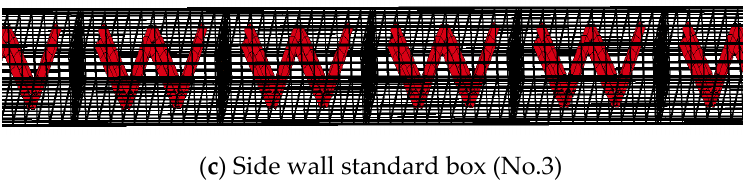
Figure 7. Finite element model of reinforcement and supporting elements.